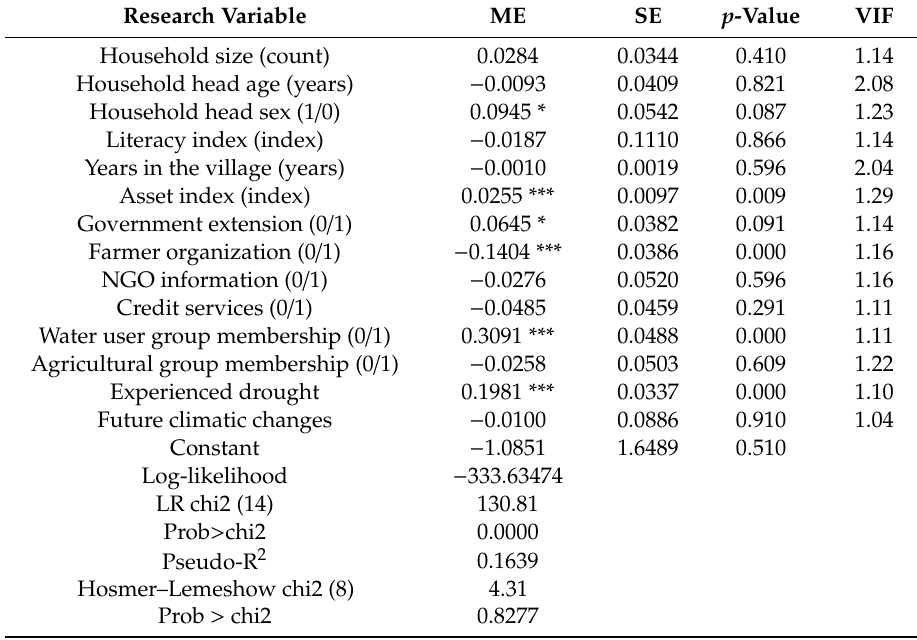
Table 2. Determinants of adopting farmer-led